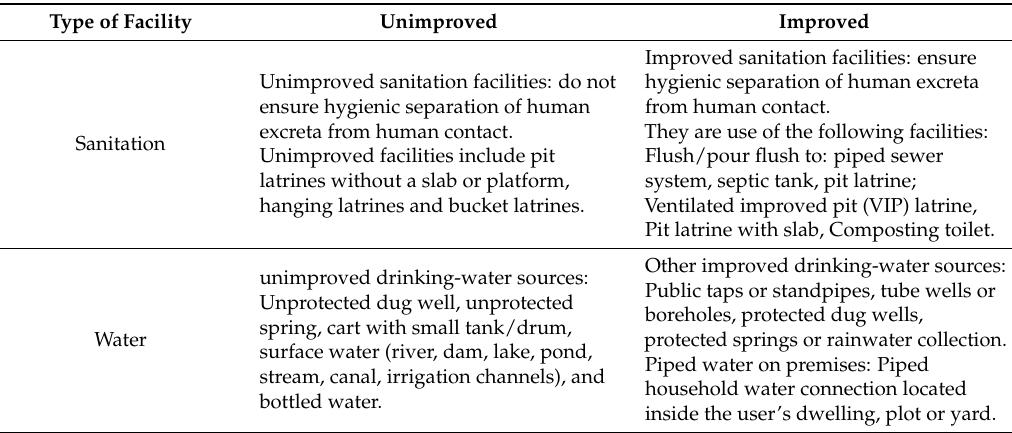
Table 1. World Health Organization (WHO) classification of improved sanitation and water supply.